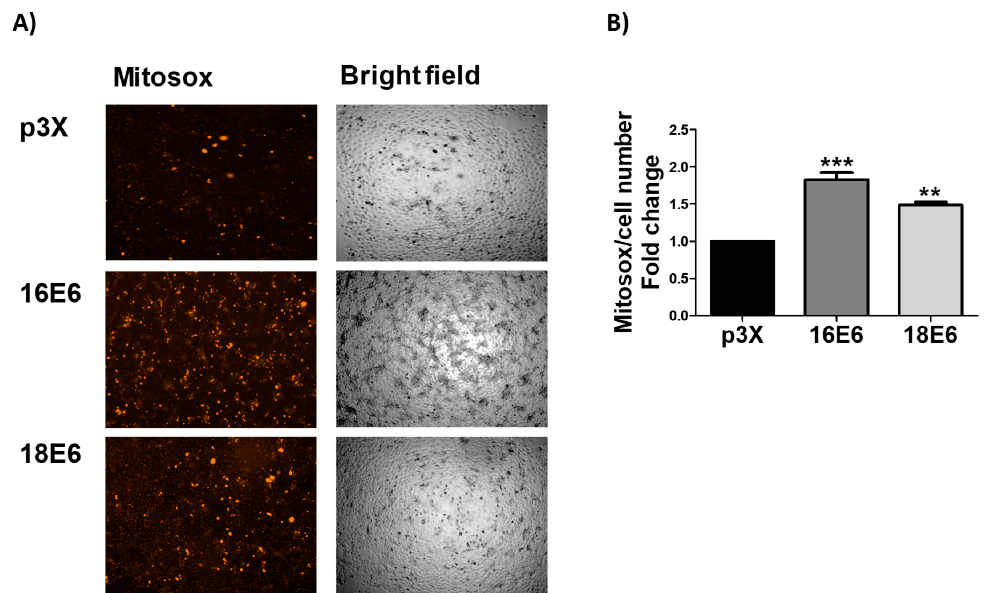
Figure 5. E6 oncoproteins from HPV16 and HPV18 increase reactive oxygen species (ROS) in mitochondria of FaDu cells. ( A ) Representative images and ( B ) quantitative data of ROS generated by E6 proteins from HPV types 16 and 18. Quantitative data were obtained from cells expressing E6 from each viral type, comparing with p3X-transfected cells. The mean intensity of MitoSOX fluorescence was measured using Gen5 TM 3.0 software for image acquisition and quantification. The fluorescence intensity is expressed as the mean ± SD. Tukey’s test ** p < 0.005 and *** p < 0.0005 vs. control (p3X), n = 3.